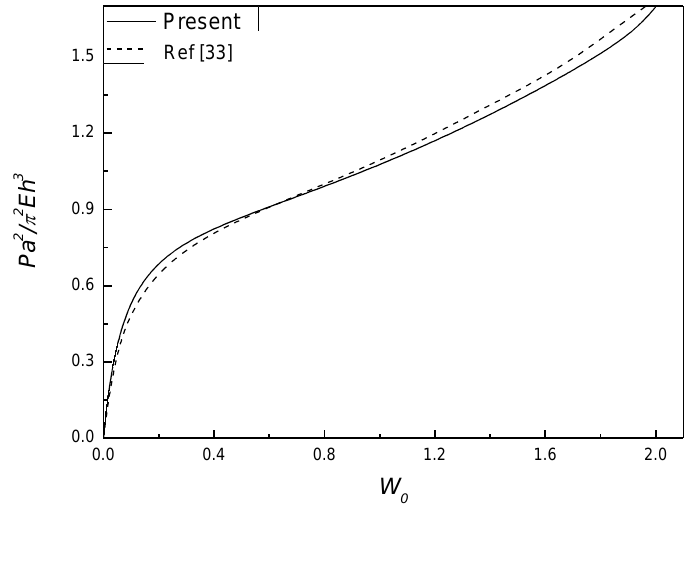
Figure 3. Comparison of postbuckling response curves for isotropic rectangular plate with initial deflection )3/1,1.0(   W 0